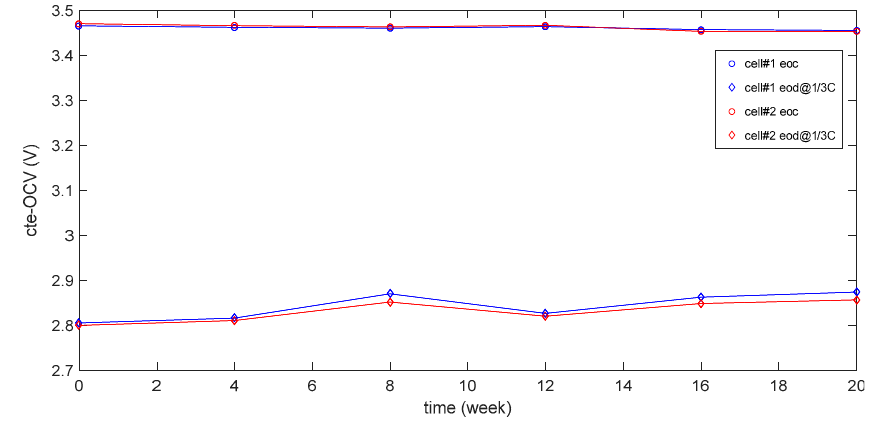
Figure 7. Relaxed cell voltage during constant current charge and discharge at C/3. cte-OCV: close-to-equilibrium open circle voltage.